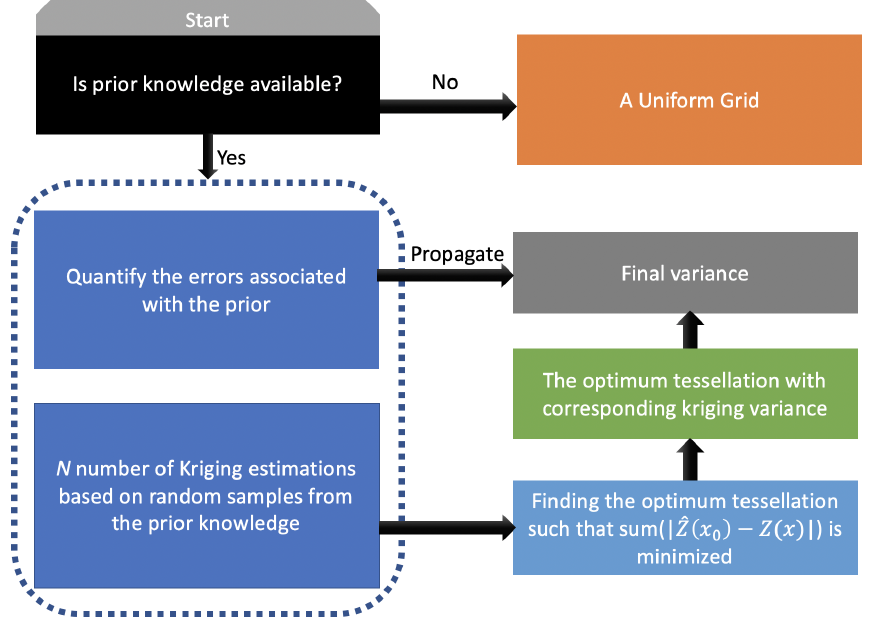
Figure 4. A schematic illustrating a framework for optimum sampling (tessellation) strategy. The prior knowledge refers to any data being capable of describing our quantity of interest including site visits, theoretical models, satellite observations, and